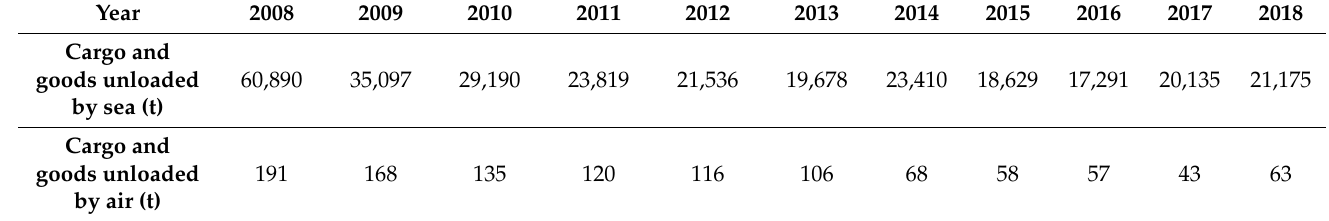
Table 1. Cargo and goods unloaded by sea and by air in Porto Santo. (Source: Authors).